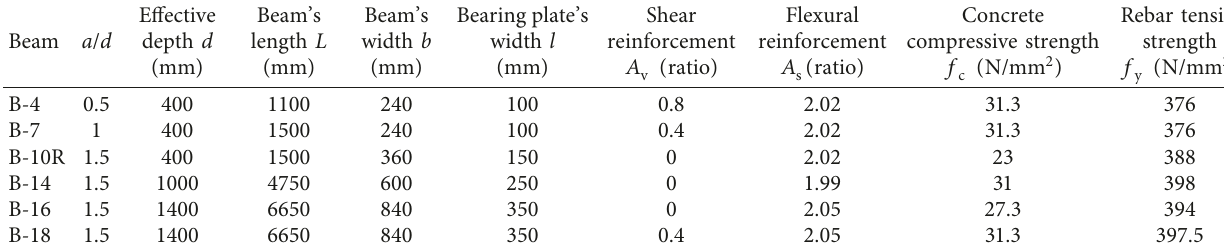
Figure 3: Schematic view of deep concrete beams [39]. Table 2: Geometry and properties of deep concrete beams.